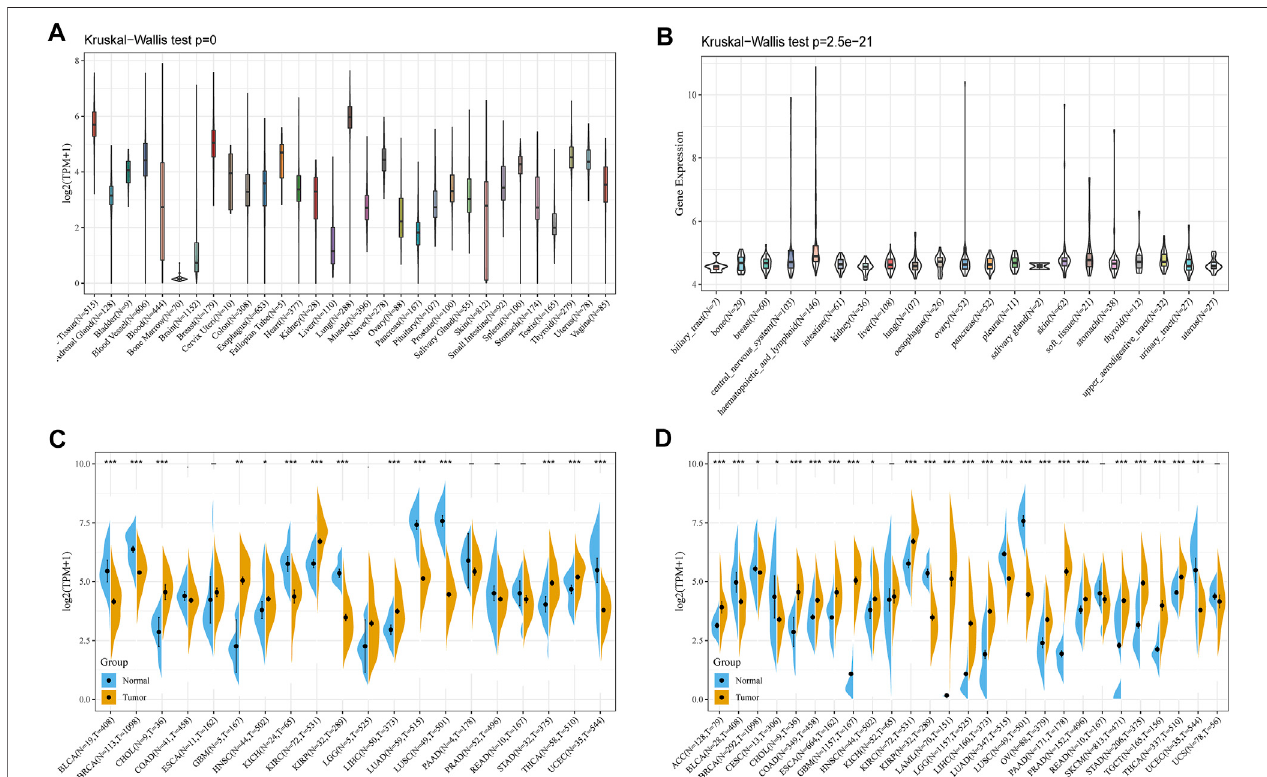
FIGURE 1 | Expression analysis of CD93. (A) CD93 expression in various normal tissues. (B) CD93 expression in different tumor cell lines. (C) CD93 expression in the TCGA database. (D) Comparison of CD93 expressions between tumors and normal samples in the TCGA and the GTEx databases. * p < 0.05, ** p < 0.01, *** p <